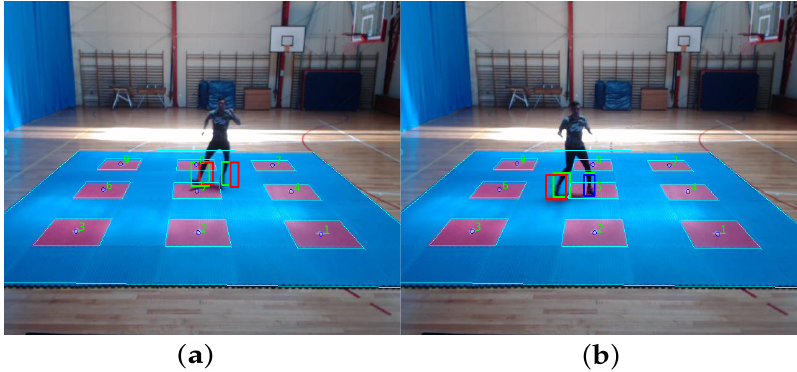
Figure 8. Kalman filter prediction and footstep detection stage for reinitialization and positive footstep detection. ( a ) Kalman filter prediction and reinitialization for both foots. ( b ) Kalman filter prediction and left footstep